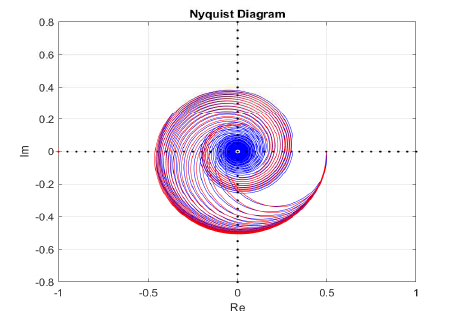
[0 , 50] and h = 0 . 1 : 0 . 1 : 2. ∈